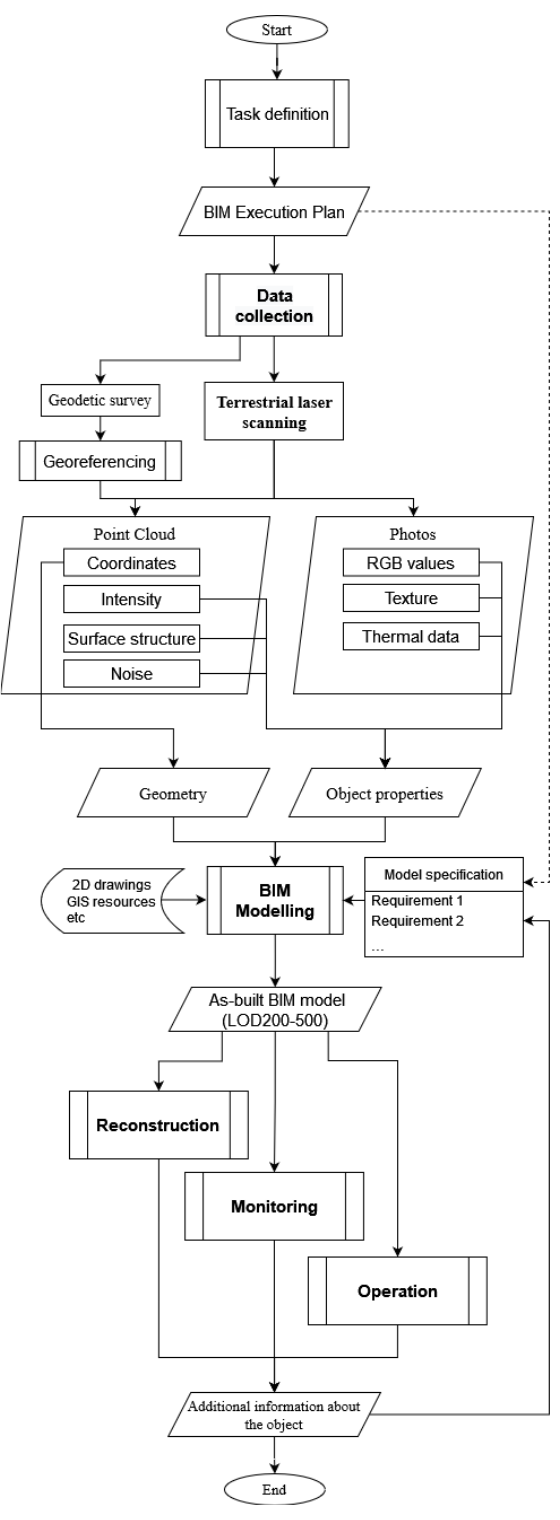
Figure 1. BIM Modelling workflow for cultural heritage objects. The speed of modern scanners reaches 2 million points per